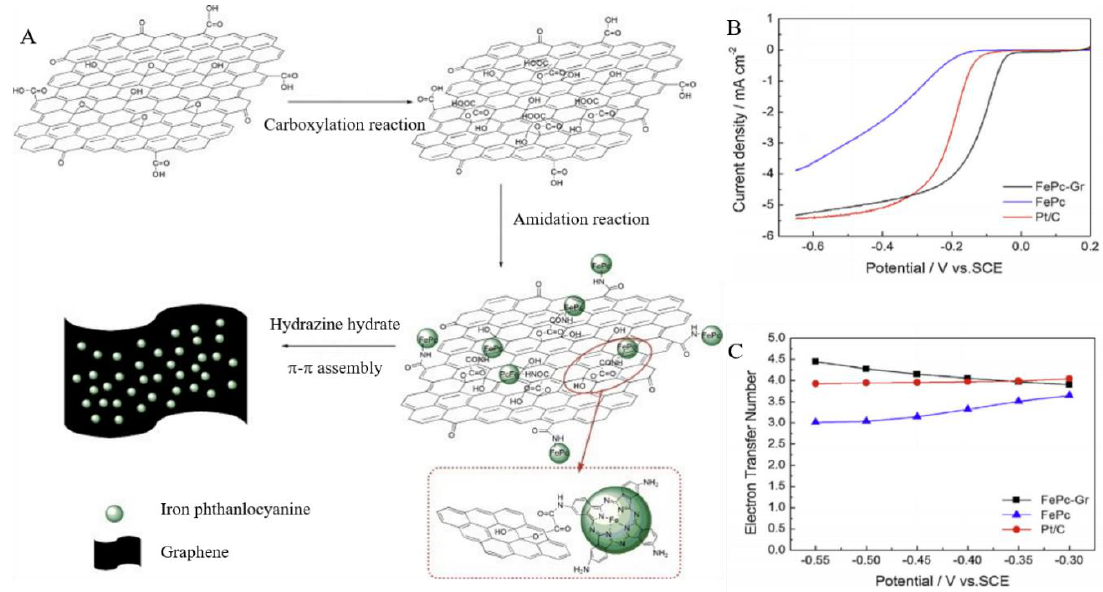
Figure 6. ( A ) The synthetic route of the FePc-Gr composite catalyst, ( B ) LSC curves of FePc-Gr, FePC, and Pt / C in O 2 -saturated 0.1 M NaOH at a scan rate of 10 mVs − 1 , and ( C ) the number of electrons transferred at di ff erent potentials of FePc-Gr, FePC, and Pt / C adapted from ref [51] Copyright 2013